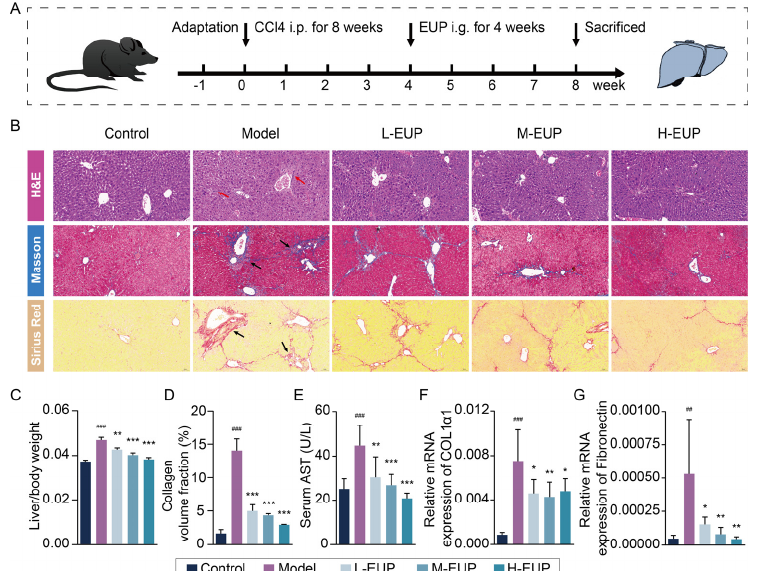
Figure 6. Eupatilin alleviates hepatic fibrosis in CCl4-induced mouse models. ( A ) The scheme of animal experiments in present study. The grouping was as follows: Control; Model (CCl4, without EUP treatment); L-EUP (CCl4, 10 mg/kg EUP); M-EUP (CCl4, 20 mg/kg EUP); H-EUP (CCl4, 40 mg/kg EUP). ( B ) Representative images of livers stained with H&E, Masson, and Sirius red (Red arrows represent mononuclear cell infiltration, black arrows represent collagen deposition. Scale bars = 50 μ m). ( C ) The ratios of liver weight to body weight in different groups (mean ± SD, n = 6). ( D ) Analysis of collagen volume fraction of Masson staining. ( E ) Serum levels of AST in CCl4-induced mice (mean ± SD, n = 6). ( F , G ) Relative mRNA expression of COL1 α 1 and Fibronectin in liver tissues (mean ± SD, n = 6). ## p < 0.01 and ### p < 0.001 vs. control group. * p < 0.05, ** p < 0.01 and *** p < 0.001 vs. model group. p values are calculated by one-way ANOVA followed by the Tukey’s test. CCl4: Carbon tetrachloride; i.p.: Intraperitoneal; i.g.: Intragastrical; EUP: Eupatilin; H&E: Hematoxylin and eosin; L-EUP: Low-dose eupatilin; M-EUP: Middle-dose eupatilin; H-EUP: High-dose eupatilin; AST: Aspartate aminotransferase; COL1 α 1: Collagen type I alpha 1.